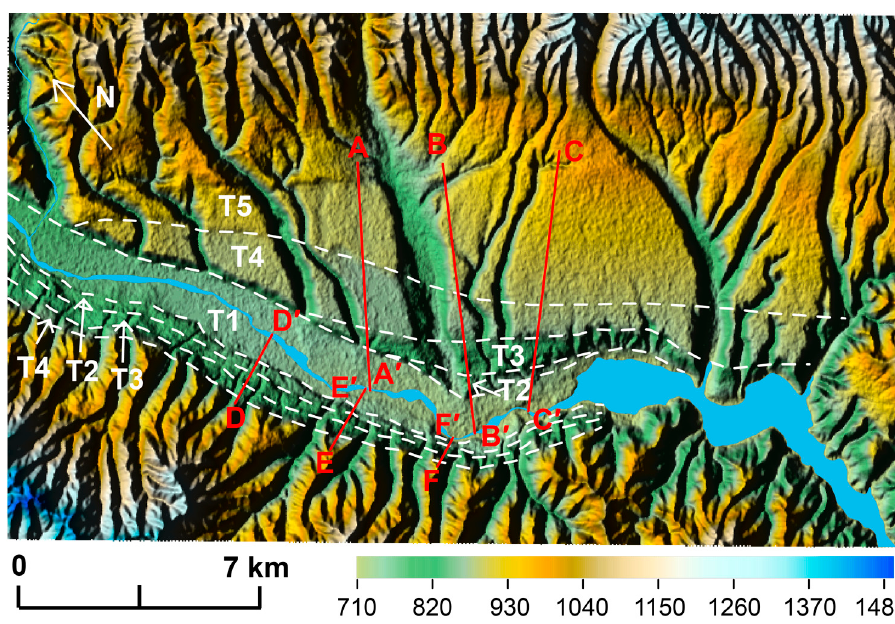
Figure 10. The river terraces in Qian Basin. The white dotted lines are the boundaries of terraces in the Qianhe Basin, modified from [35,74]. The red lines (AA ′ , BB ′ , CC ′ , DD ′ , EE ′ , and FF ′ ) are the topographic profiles of the terrace height.